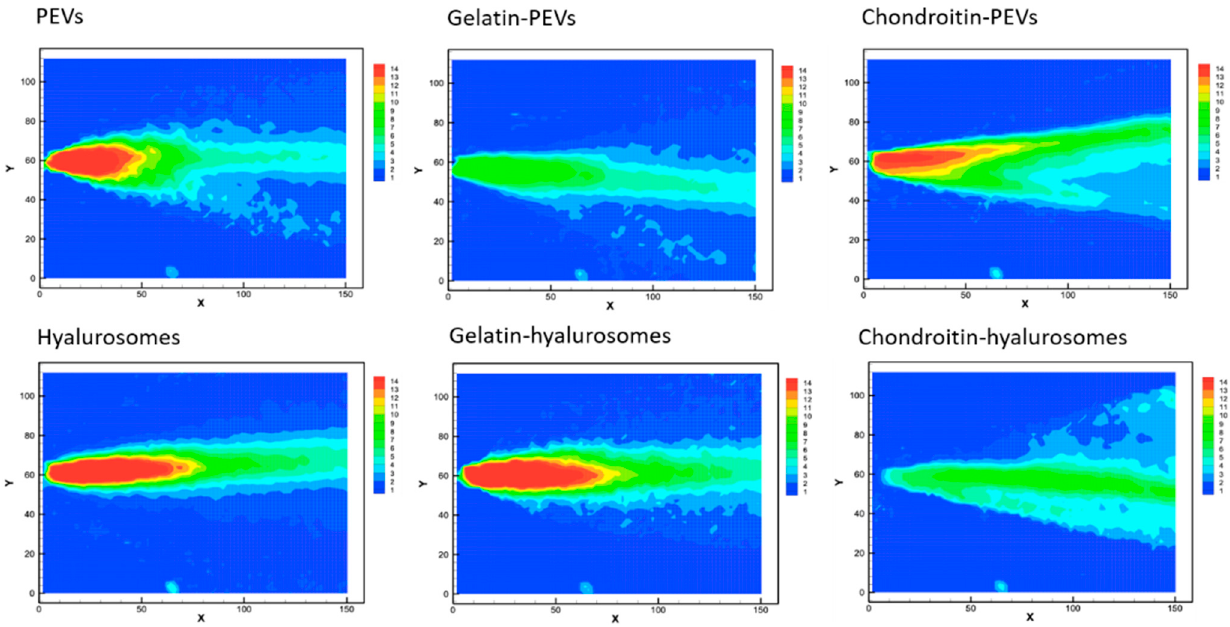
Figure 4. Representative images of average drop speed generated by the spray of the extract loaded PEVs; gelatin-PEVs; chondroitin-PEVs; hyalurosomes; gelatin-hyalurosomes; and chondroitin-hyalurosomes. Red indicates high velocity, yellow indicates intermediate velocity, and green and light-blue indicate low velocity.